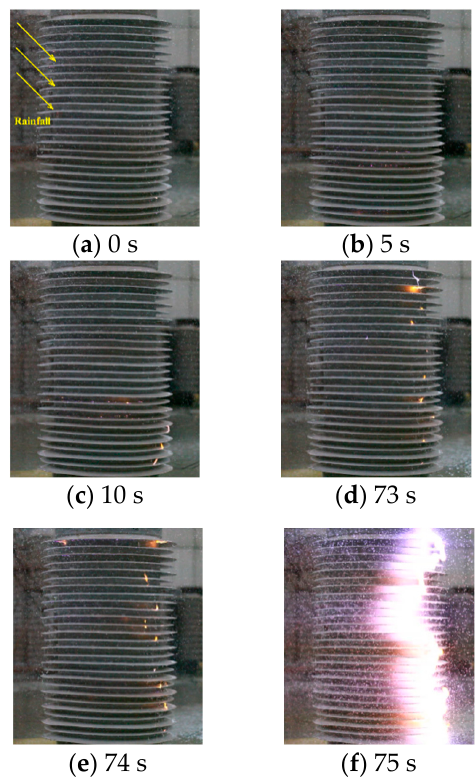
Figure 6. Process of contaminating rain flashover of the large-diameter composite post insulator. ( a ) start the artificial rain; ( b ) 5 s after; ( c ) 10 s after; ( d ) 73 s after; ( e ) 74 s after; ( f ) 75 s after.